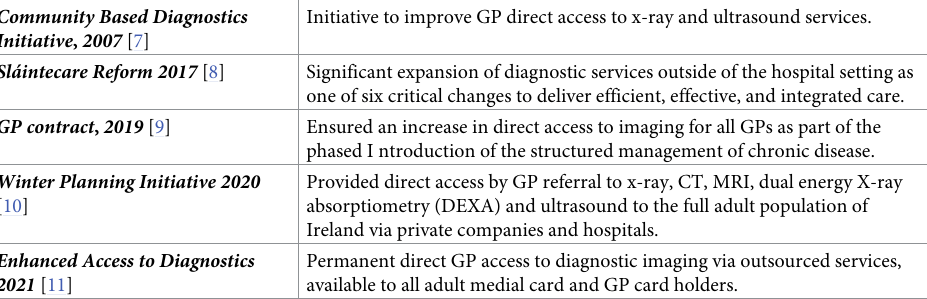
Table 1. Direct access to diagnostic imaging in general practice schemes in